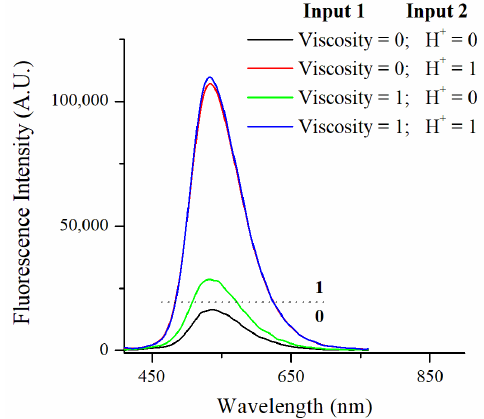
Figure 5. OR molecular logic gate based on probe 3 using different viscosity and protons as inputs.